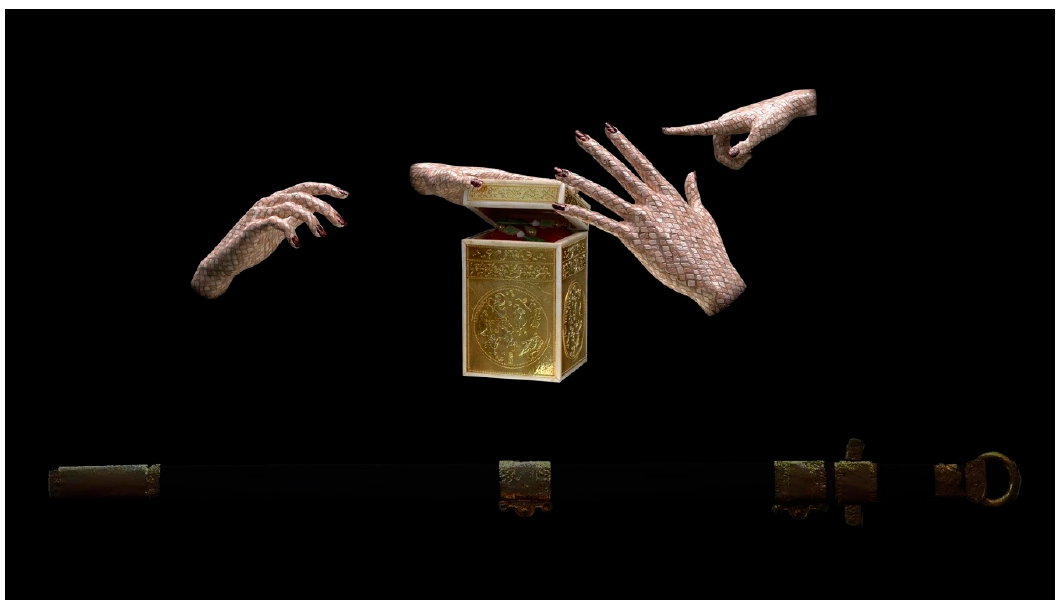
Figure 25. Scene of the Kunàgota sword’s story: everything must look as it was happening in front of the visitor’s eyes, from a fixed point of view, in real scale, self-contained in the frame. Audio-visual grammar includes some of the following